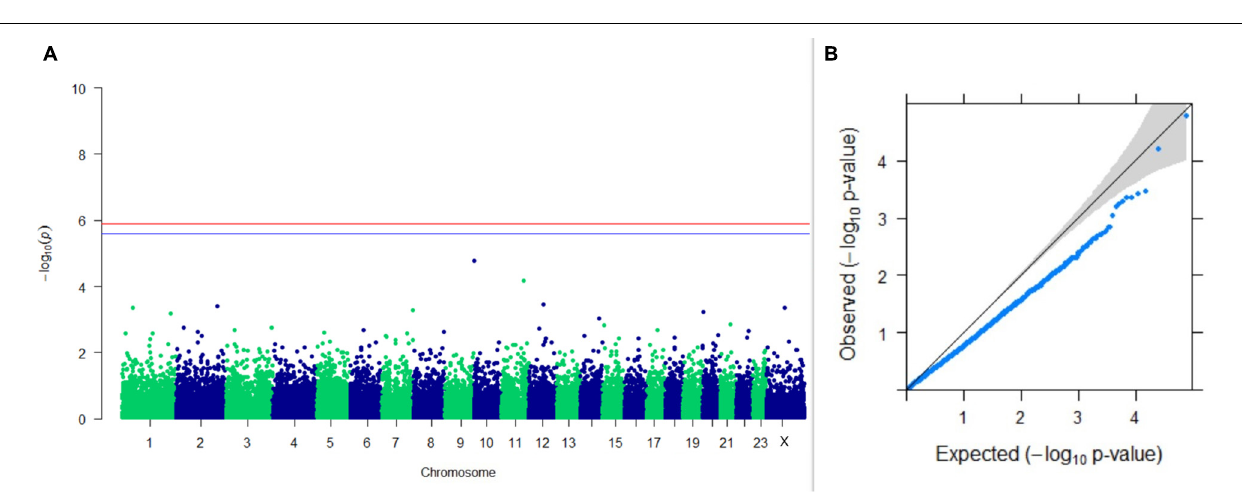
FIGURE 14 | Results of GWAS for breeding efficiency. (A) Manhattan plot of genome-wide SNPs. The red line indicates the p- value threshold (expressed as –log 10 P ) corresponding to FDR-corrected p- values or q = 0.05, above which the SNPs are considered to be significantly associated with the trait, while the blue line indicates the genome-wide suggestive threshold at q = 0.1. The SNPs identified on chromosome no. 24 were screened out from analysis because of stringent quality control; hence, it is not represented in the Manhattan plot (B) Q-Q plot of the p-